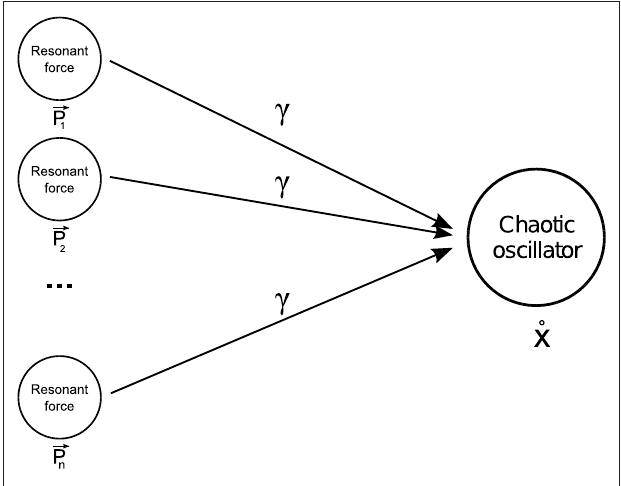
FIGURE 2 | Phase synchronization. For specifi c coupling values γ , a chaotic system is able to match and combine the natural resonance frequencies of two or more forces.